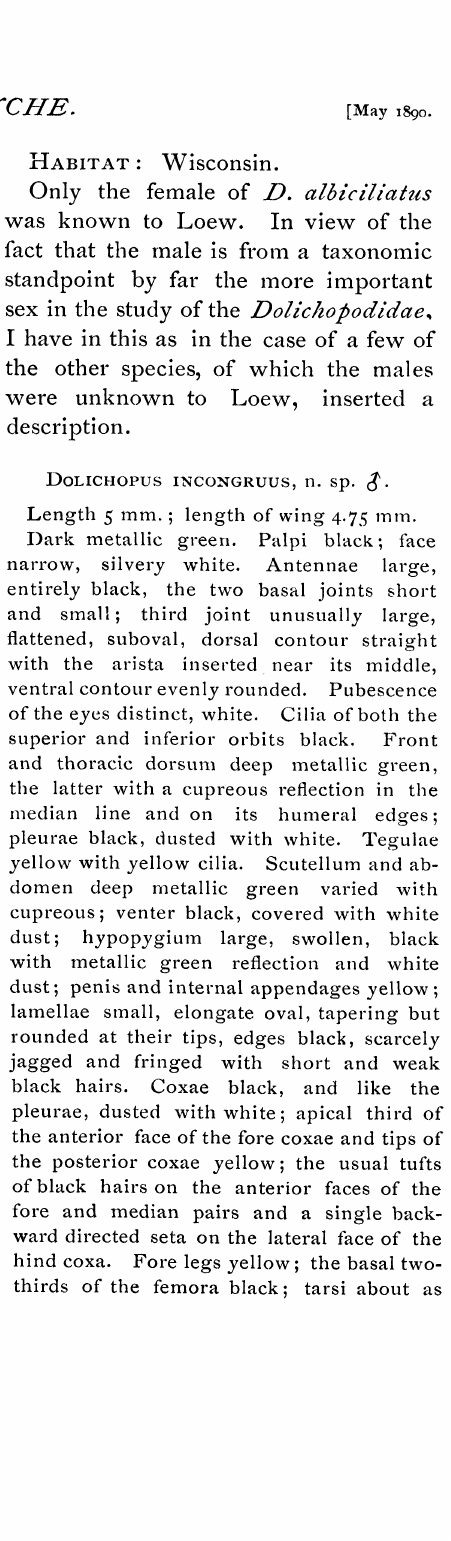
ments with violet reflection incisures broad- ly black; renter black, powdered with white dust; hypopygium black, opaque, with pale dull yellow lamellae of subtriangular outline,